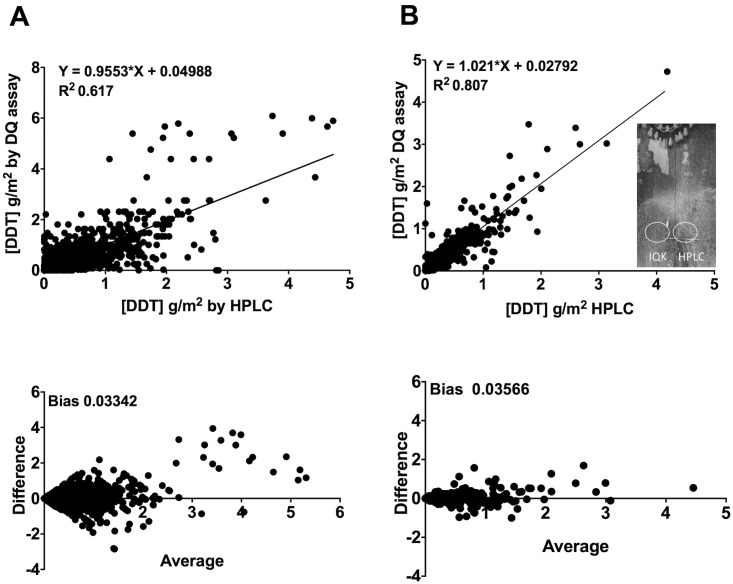
Comparison of DDT quantification of field samples by IQK and HPLC (non pooled).A. correlation of individual sample pairs (n = 1964 samples), R2 0.617 (top), and Bland Altman bias, 0.03342 (bottom); B. correlation of average household values for sample pairs (n = 491 samples), R2 0.617 (top), and Bland Altman bias, 0.03566 (bottom). Inset picture shows typical white DDT powder residue with IQK and HPLC sample areas circled.